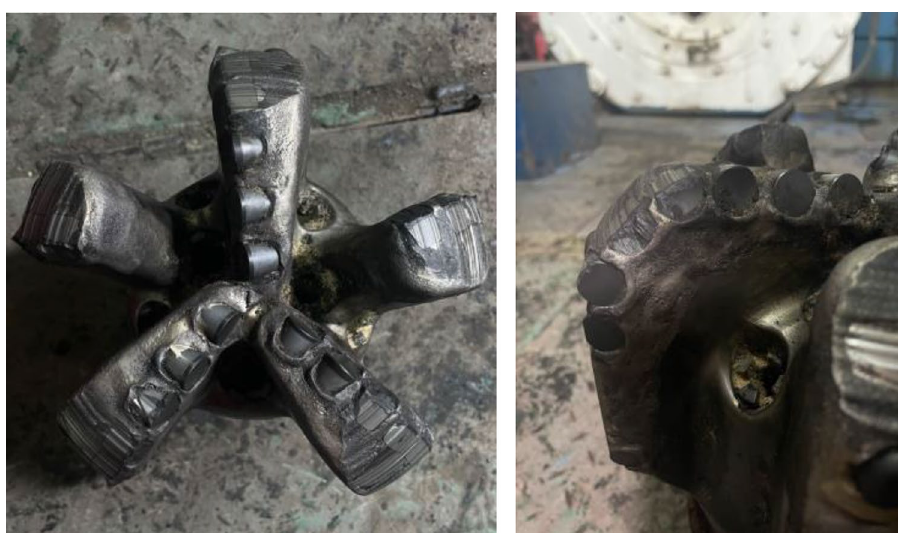
Fig. 21 Flat cutter bit after